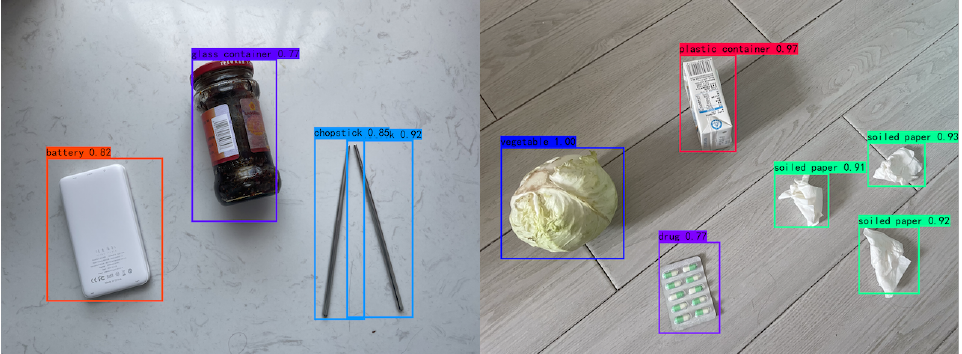
Figure 11. Detection results of garbage